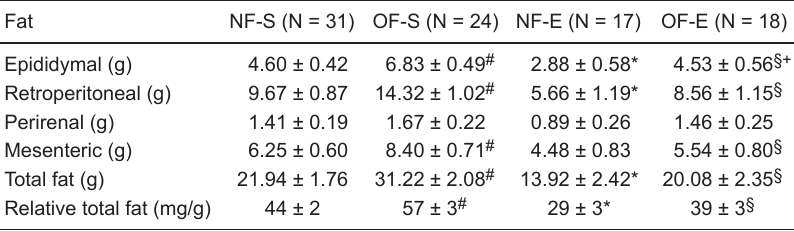
Data are reported as means ± SEM. NF-S = normally fed sedentary; OF-S = overfed sed- entary; NF-E = normally fed exercised; OF-E = overfed exercised. The symbols indicate significant differences (P < 0.05) between NF-S and NF-E (*), OF-S and OF-E (§), NF-S and OF-S (#), NF-E and OF-E (+) (two-way ANOVA and Tukey post hoc